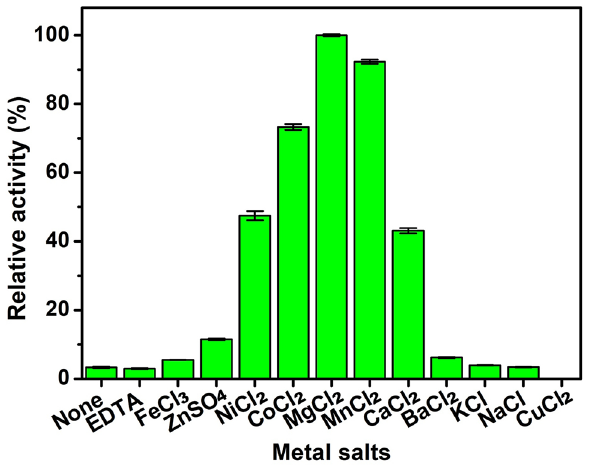
Figure 4. Relative activity of ThABF in the presence of different metallic ions.